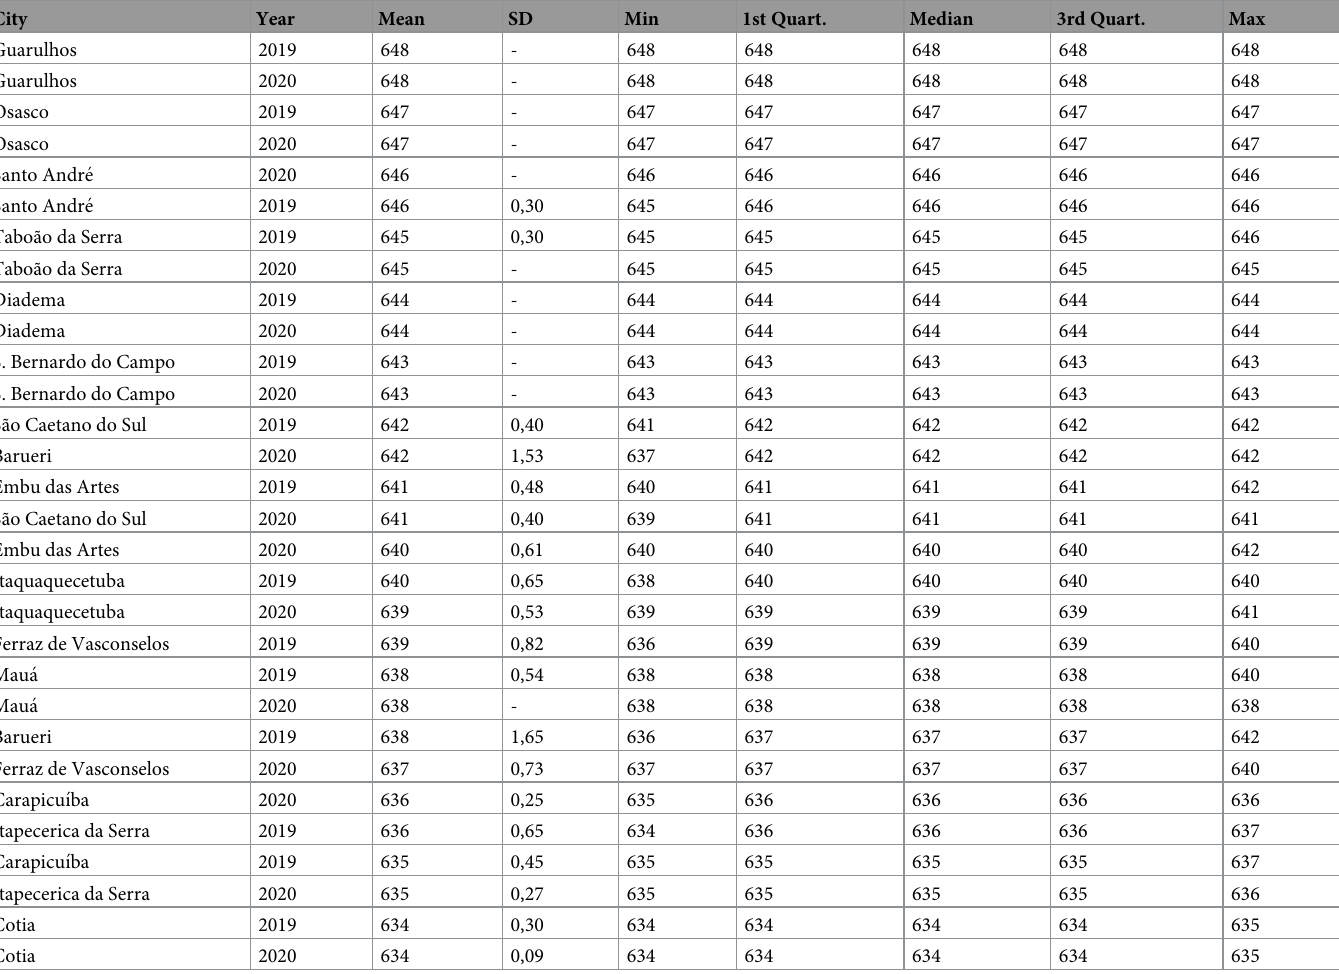
Table 2. Descriptive statistics of the rank of the proportion of movement out of S ã o Paulo capital city in the days of March 2019 and March 2020.